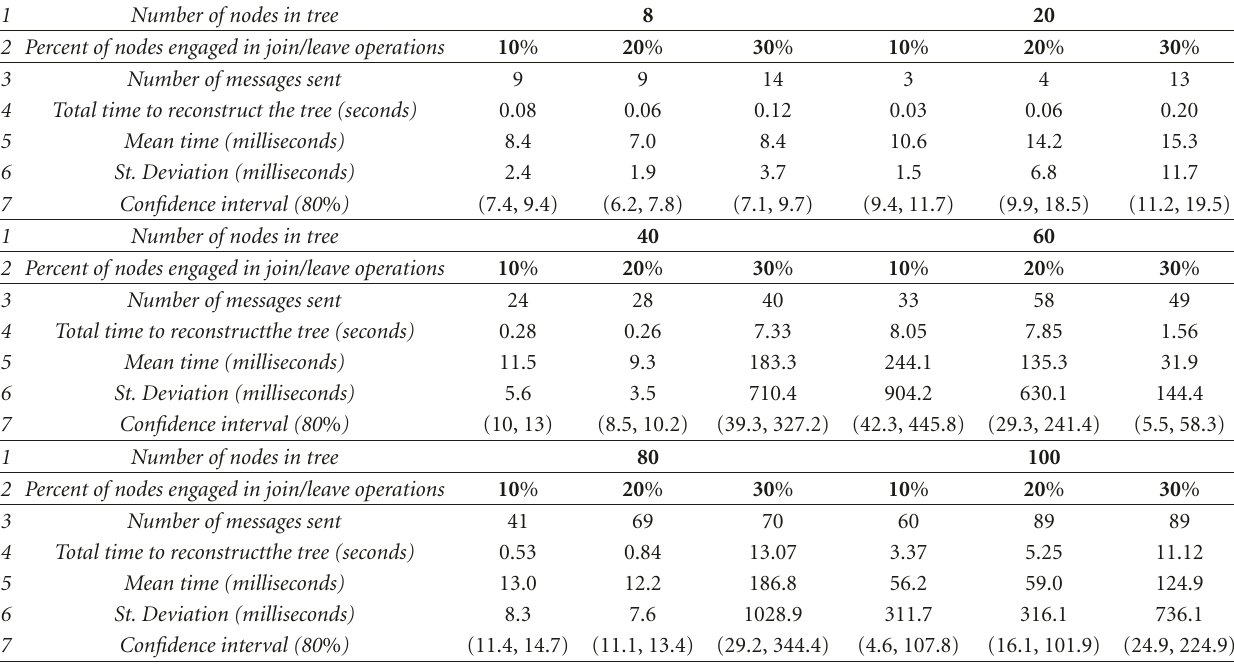
Figure 5: The simulation topology for 20 (a), 60 (b), 80 (c), and 100 (d) nodes. Table 3: Timings and metrics for join/leave